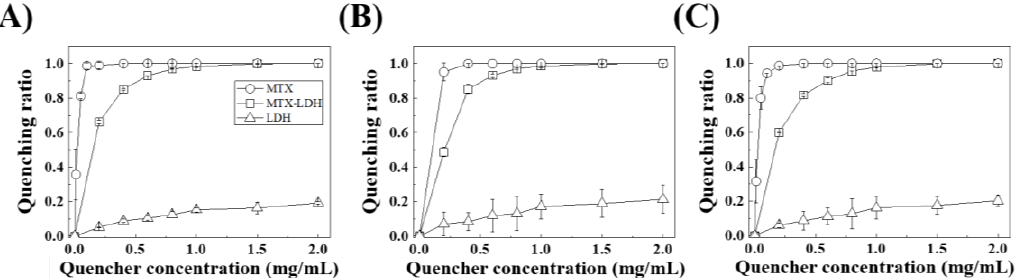
Figure 4. Plasma protein fluorescence quenching ratio of MTX-LDH, MTX and LDH, respectively, in ( A ) albumin, ( B ) fibrinogen, and ( C ) globulin (photoluminescence (PL) excitation wavelength: 280 nm, emission wavelength: 360 nm). The concentration of quenchers (MTX, LDH, and MTX-LDH) was varied at 0, 0.2, 0.4, 0.6, 0.8, 1.0, 1.5, and 2.0 mg / mL, while the concentration of protein (albumin, fibrinogen, and globulin) was fixed at 1.5 mg / mL.